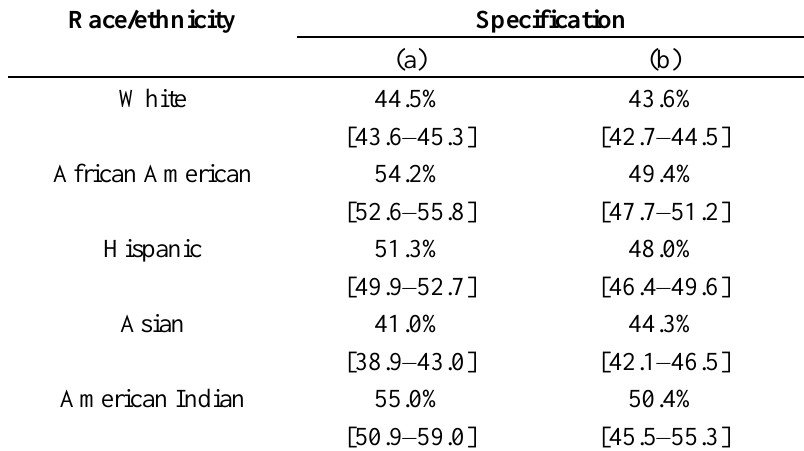
Table 3. Predicted perceived smoking prevalence by race adjusted for contextual